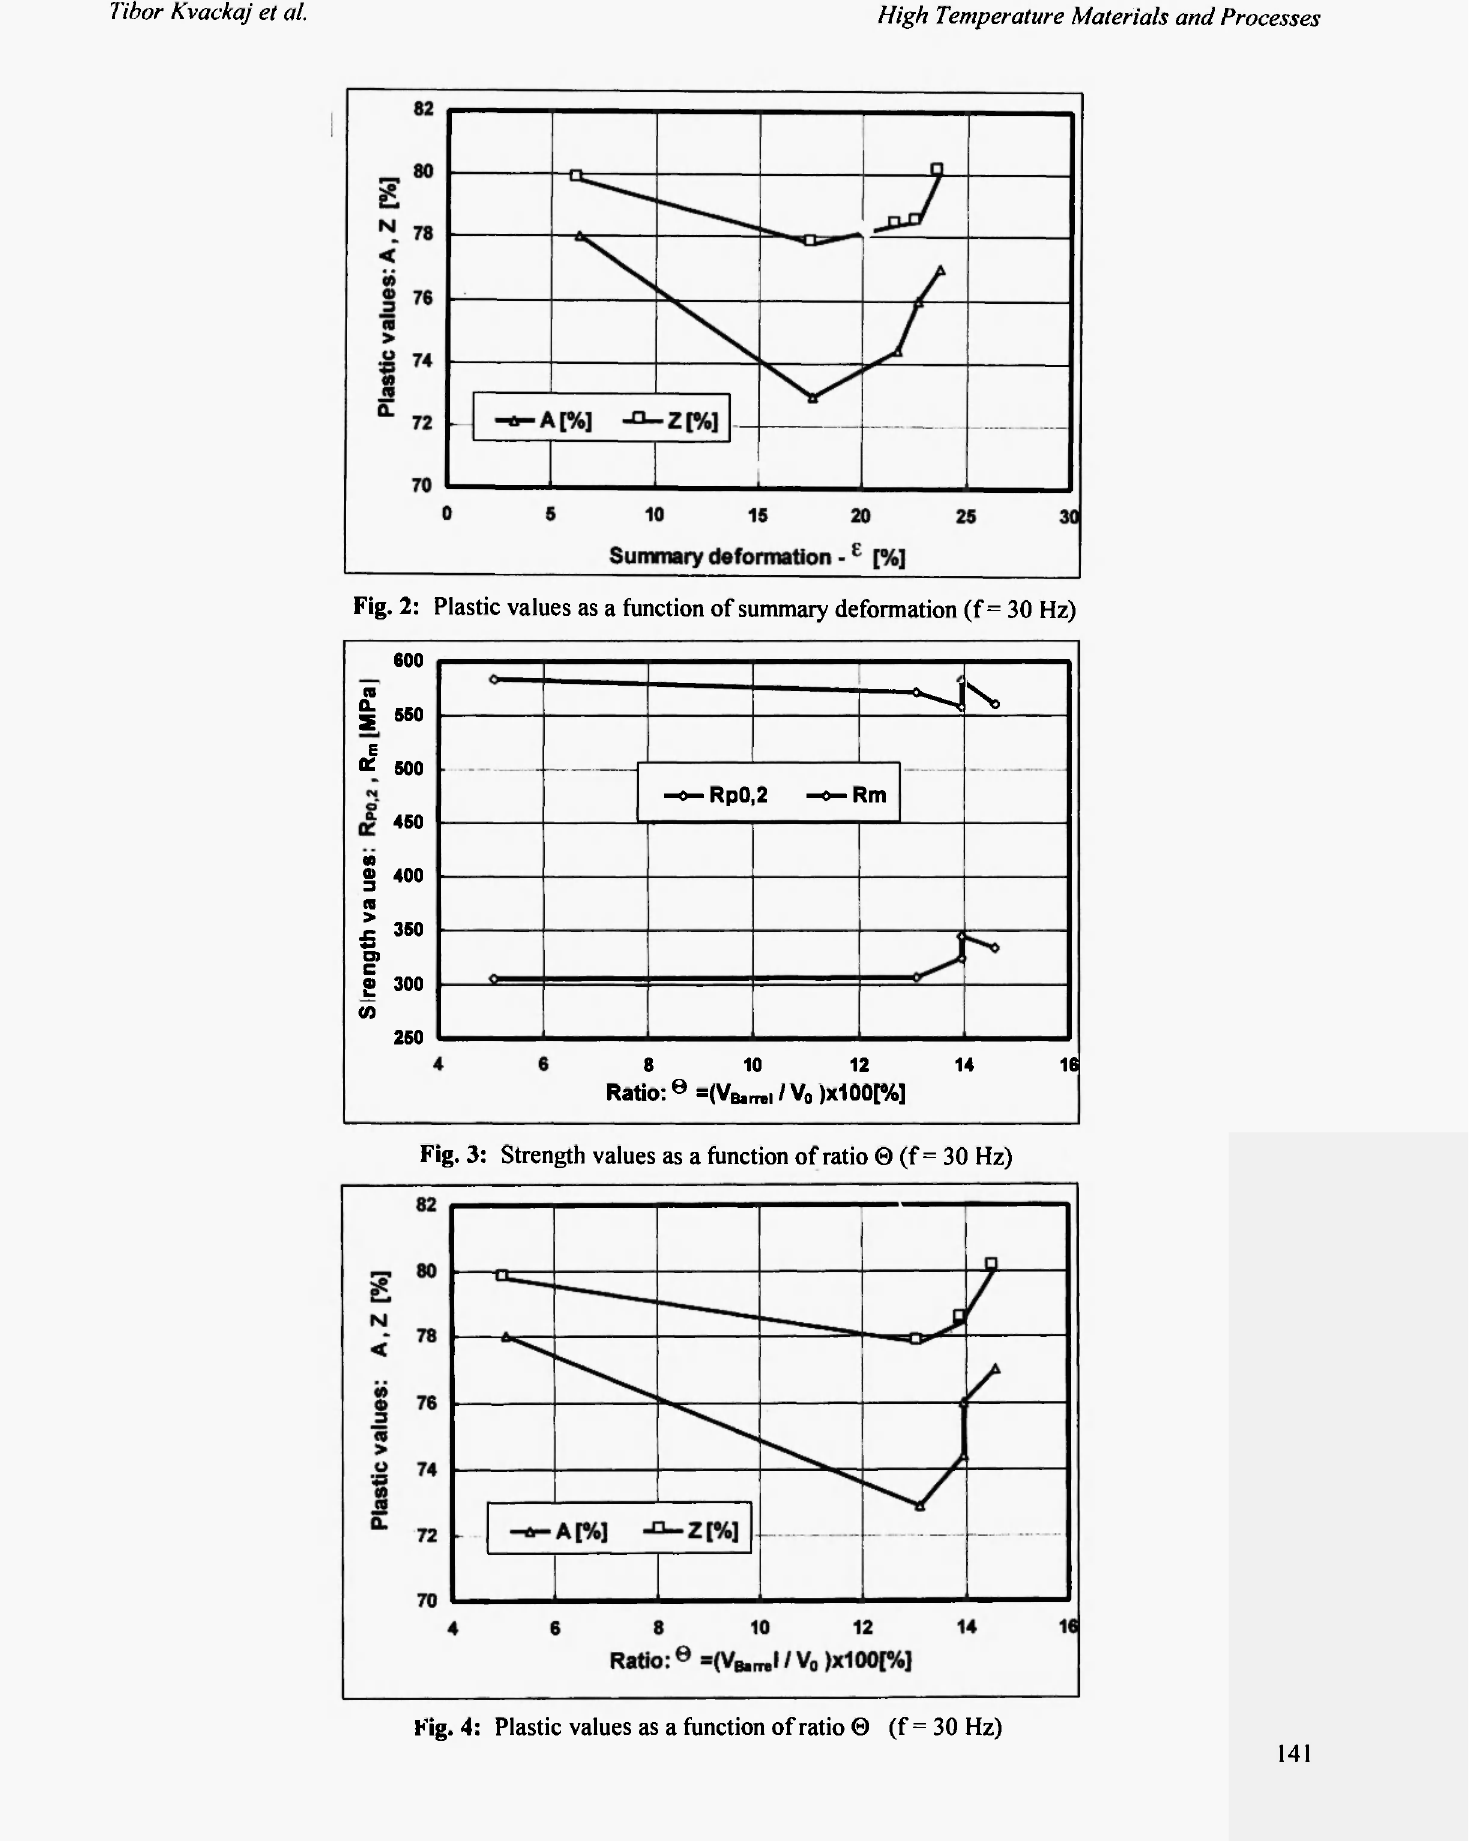
Kig. 4: Plastic values as a function of ratio Θ (f = 30 Hz)